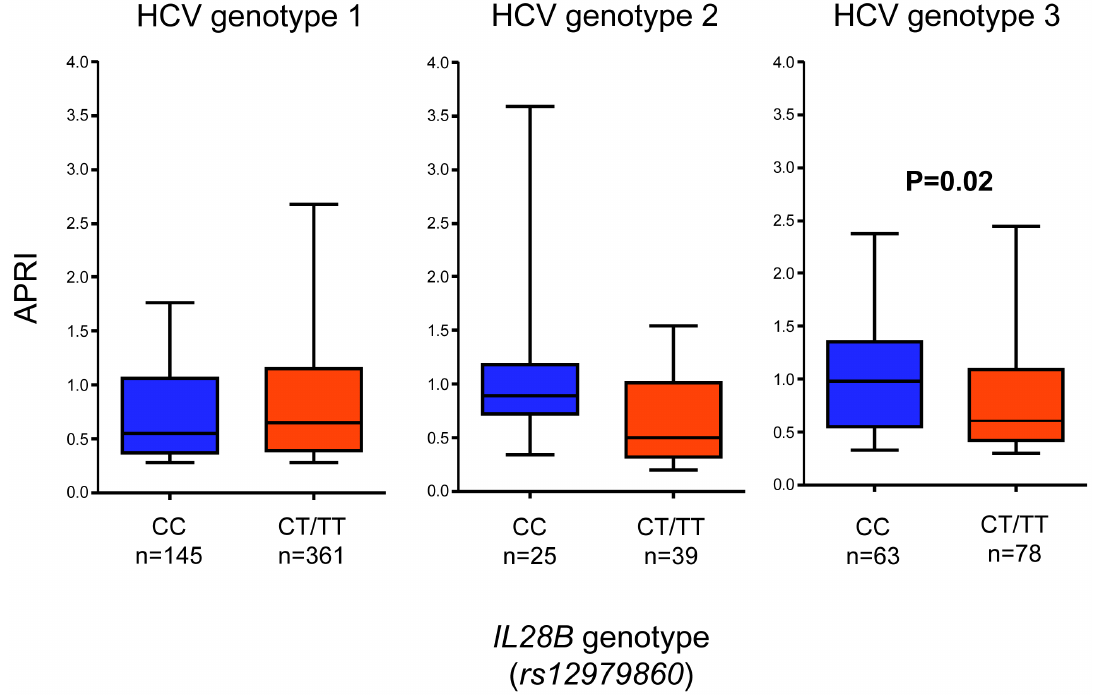
Figure 4. Tenth, 25 th , 50 th , 75 th , and 90 th percentiles of APRI score in relation to IL28B variants for genotypes 1, 2 and 3.